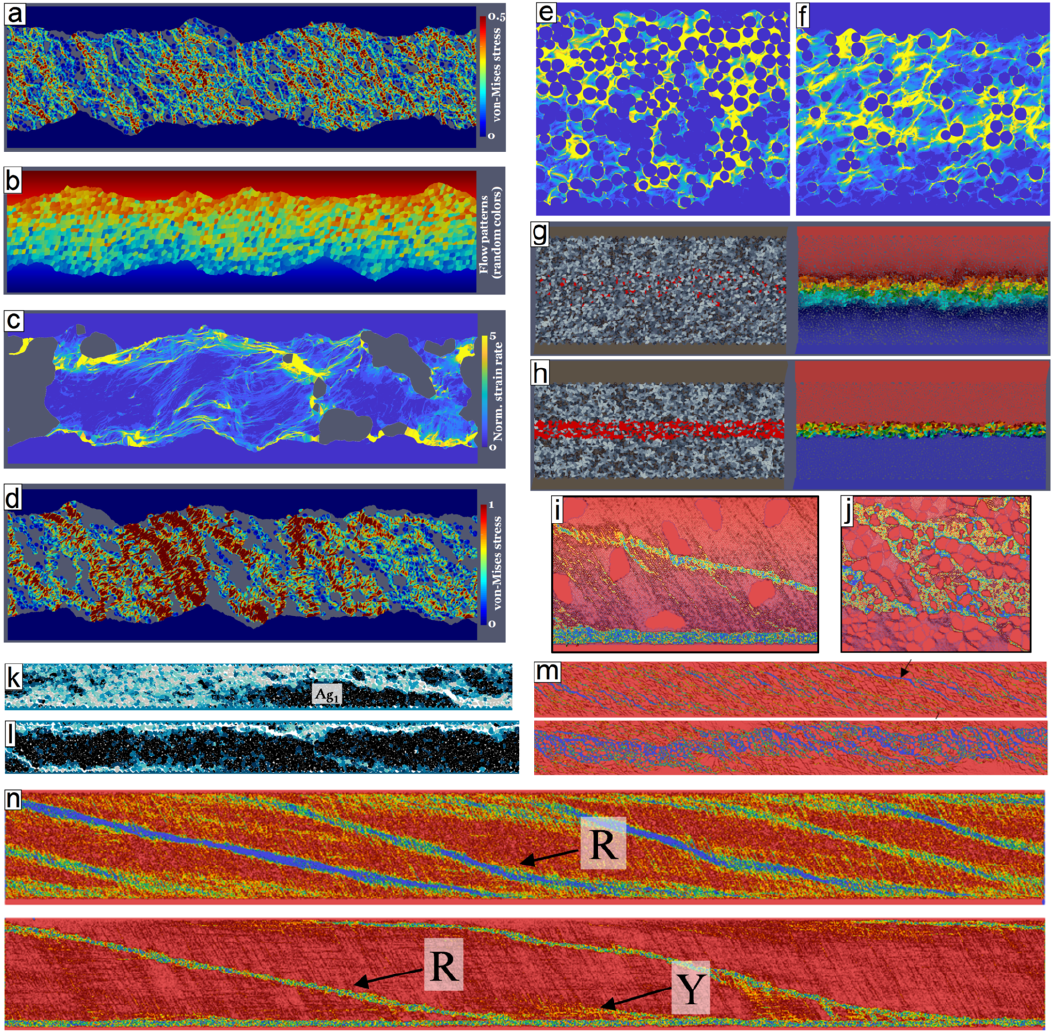
Figure 3: Overview of a variety of kinematic regimes in confined sheared granular flows. a : Force chains (hard grains) [35]; b : Plastic flow (soft and mildly cohesive grains) [35]; c : Agglomerated rolling flow (soft cohesive grains) [35]; d : Force pillars (critically soft and cohesive grains) [35]; e : Hard clusters in a mixture of 40% soft and 60% hard grains [45] (colours code shear rate); f : Short-lived localized shear bands in a mixture of 80% soft and 20% hard grains [45] (colours code shear rate); g : Moderate localization in a granular gouge with 5% of molten grains [40] (colours code horizontal displacement); h : Strong localization and quasi-viscous flow in a granular gouge with 60% molten grains [40] (colours code horizontal displacement); i : Oblique fracture and horizontal localization in a mixture of a few large grains within a fine matrix [39] (colours code solid fraction); j : Rigid aggregated formation in a mixture of many large grains with porosity filled by a fine matrix (colours code solid fraction); k : Formation of cohesive aggregates and Riedel bands in a moderately cemented gouge [38] (colours code damage); l : Riedel bands and horizontal fracture in a highly cemented gouge [38] (colours code damage); m : Progressive destructuration of a large number of oblique bands towards bulk shearing [39] (colours code solid fraction); n : Activation of five primary shear bands in a fine matrix of conforming polygonal grains, only two of them being active in a later stage of shearing [39] (R refers to Riedel shear band, Y refers to boundary shear band, colours code solid